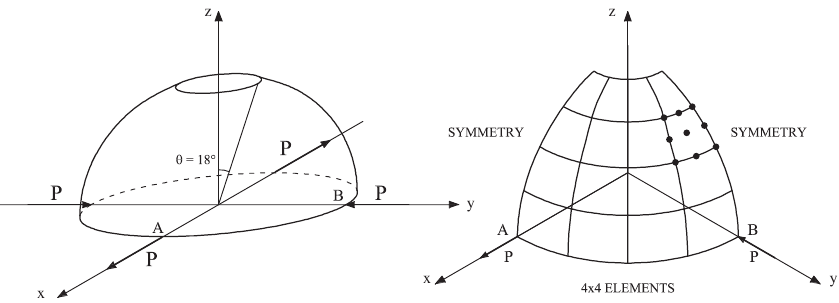
Figure 6: Numerical test example 3: a dome with opening on top (18 ∘ hole with vertical axis): geometrical properties and one element model with 9-node FE